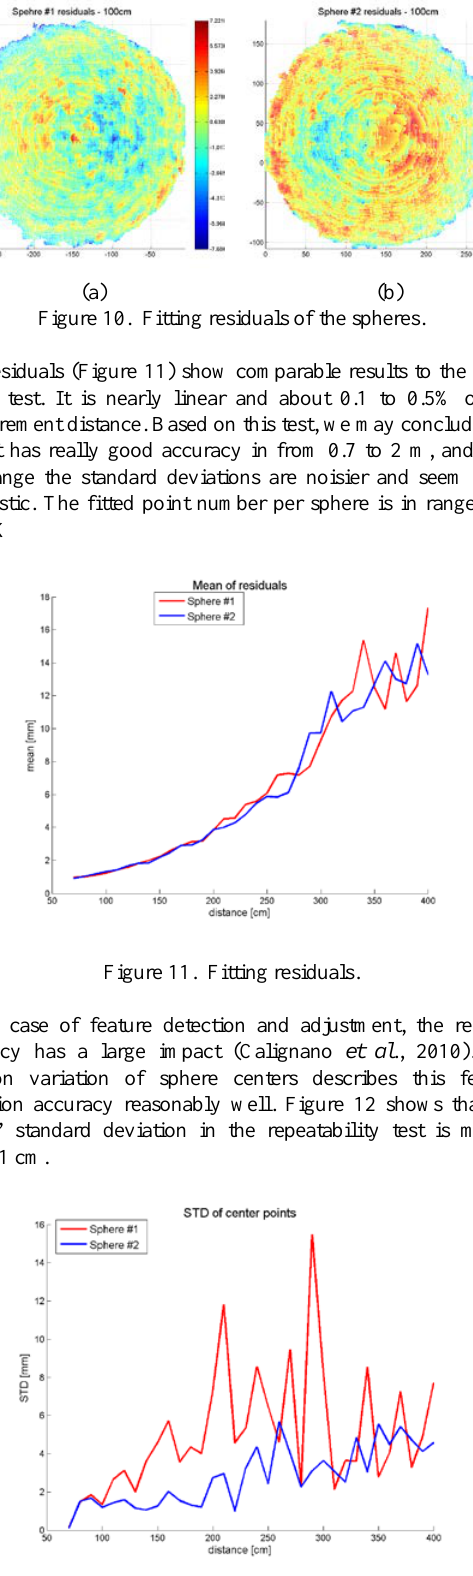
Figure 12. STD of center point location variation.